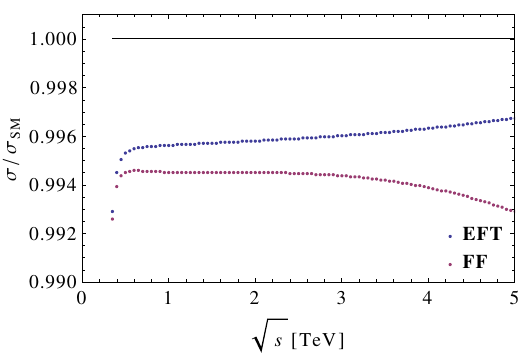
Figure 6 . Cross section for gg ! t (cid:22) t normalized to the SM as function of center of mass energy in the partially composite case (purple). The EFT case (blue) is also shown for comparison.